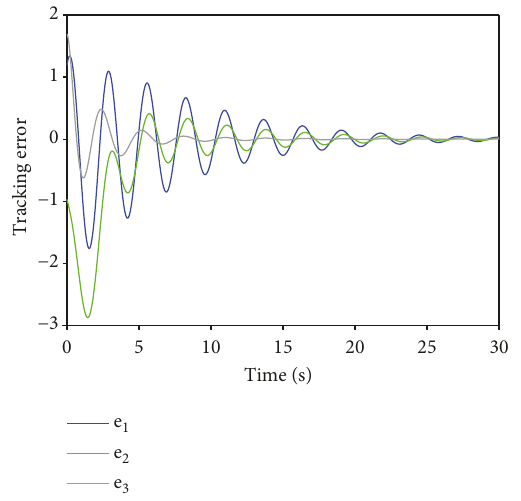
− y = y i = 1,2,3 by state-feedback i 0 i